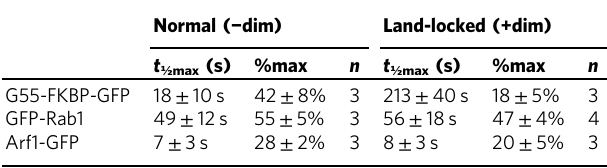
Table 1 Summary of FRAP analysis on normal or land-locked Golgi Normal ( − dim)